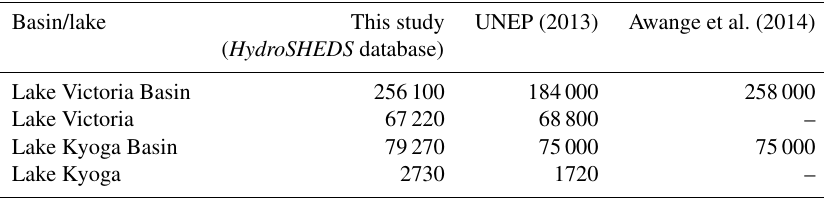
Table 1. Estimated areal extent (km 2 ) of the Lake Victoria Basin (LVB), the Lake Kyoga Basin (LKB), Lake Victoria, and Lake Kyoga.